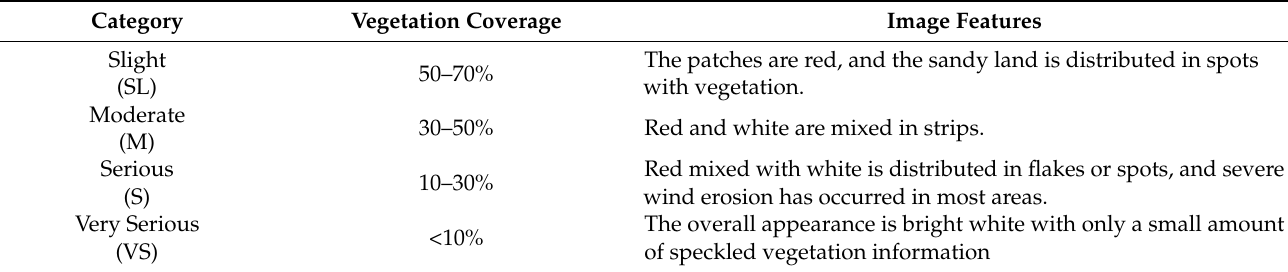
Table 1. Classification system of